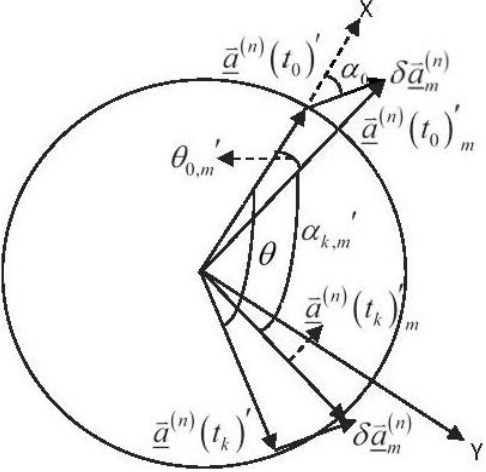
Figure 2. Projection vectors and angles on the rotation